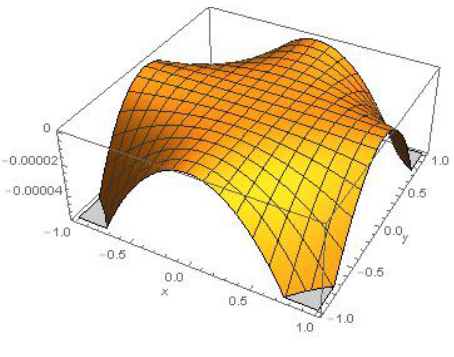
Figure 2. Case II:approximate invariant solution of Equation (28) for t = 100, − 1 ≤ x ≤ 1, − 1 ≤ y ≤ 1, ε =